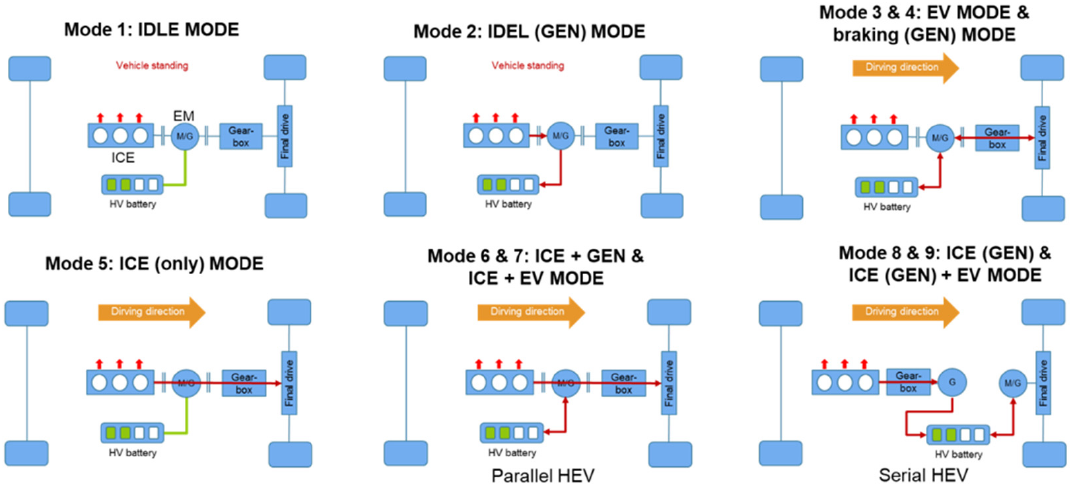
Figure 2. Examples of the different modes for the different HEV architectures.